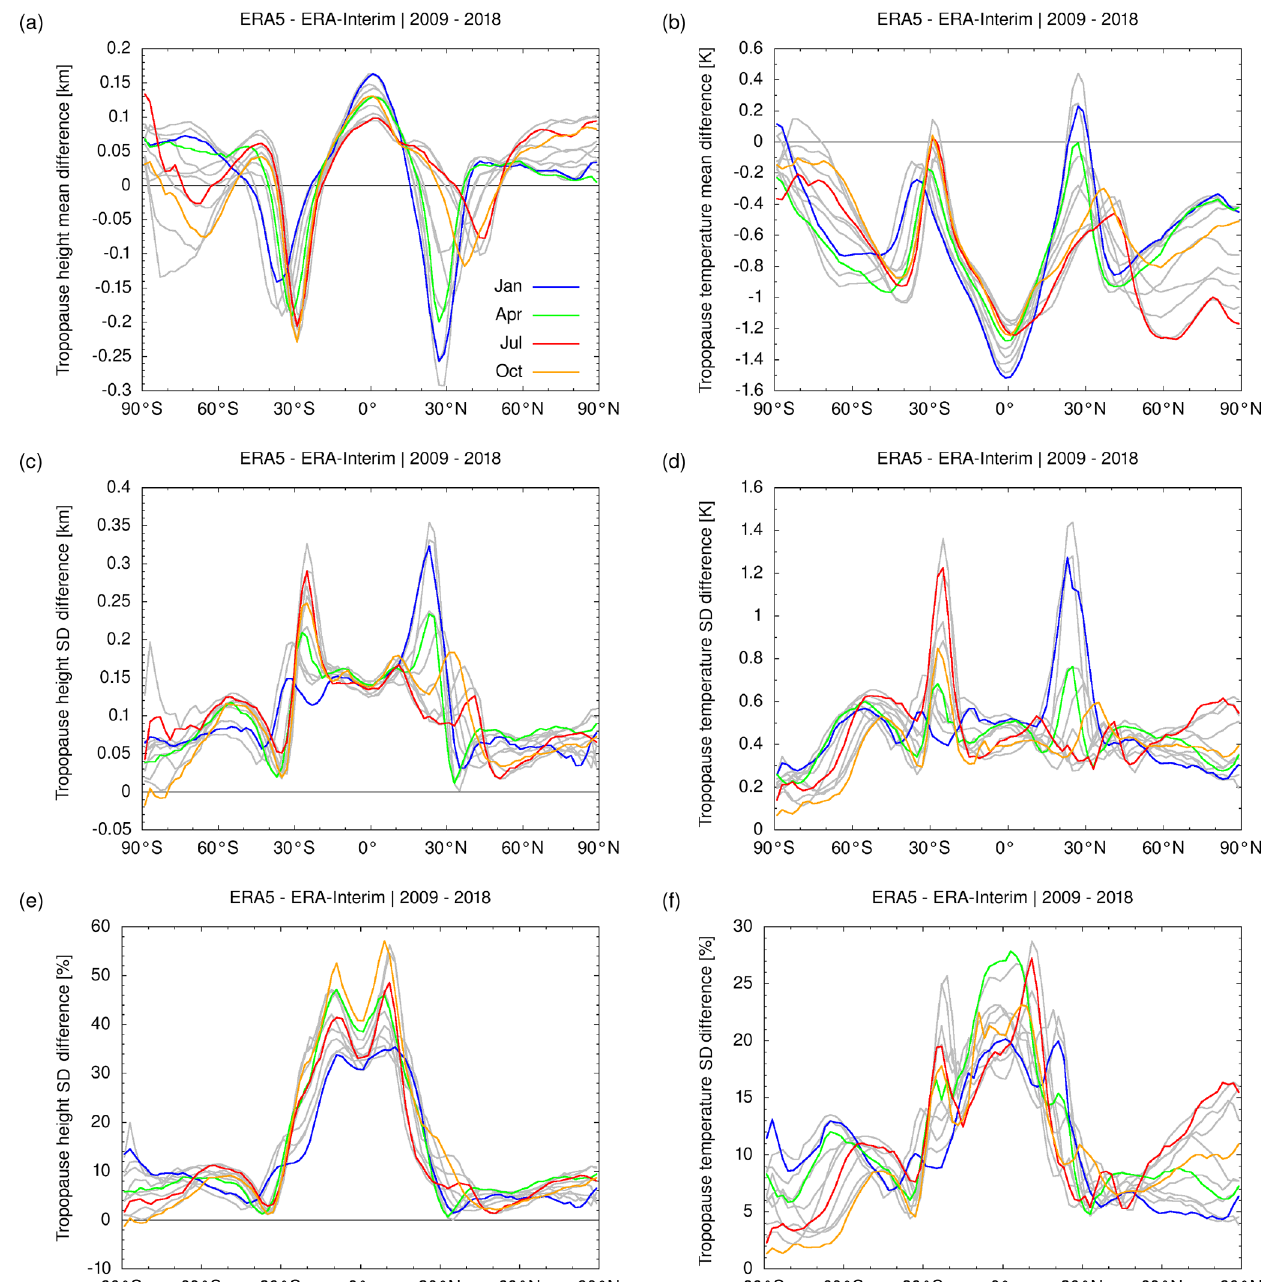
Figure 6. Monthly differences between ERA5 and ERA-Interim geopotential heights (a, c, e) and temperatures (b, d, f) during the years 2009 to 2018. The mean differences between the data sets (a, b) as well as the absolute (c, d) and relative (e, f) differences of the standard deviations are shown. The same bin size and set of samples as for Fig. 5 were used to calculate these